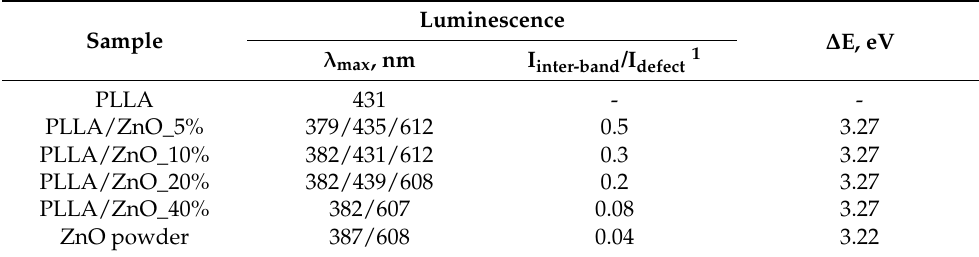
Table 2. Spectral and luminescent properties of the obtained